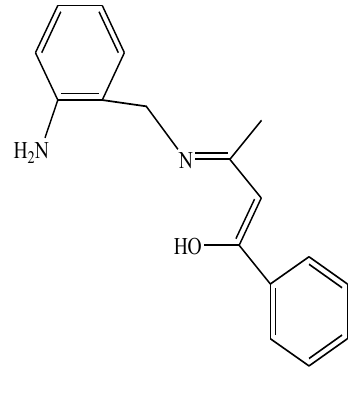
Figure 1. The BEA